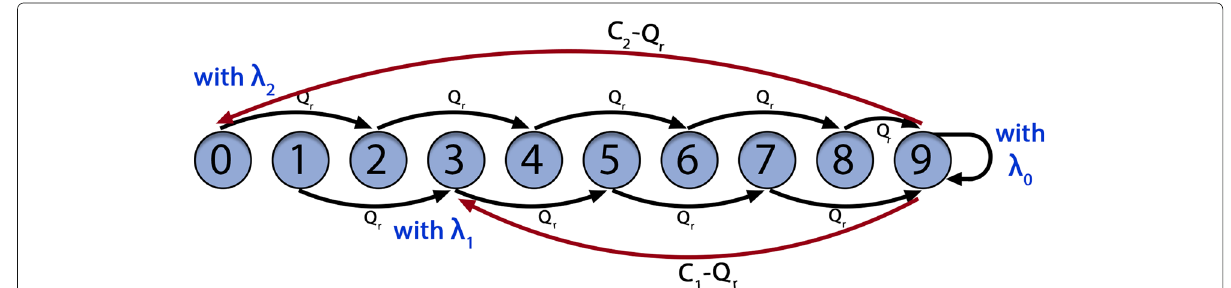
Fig. 5 Simple Markovian model of TDC. Markovian model of the TDC consumption/generation scheme. Note that each state indicates the (discretized) remaining TDC of the node in